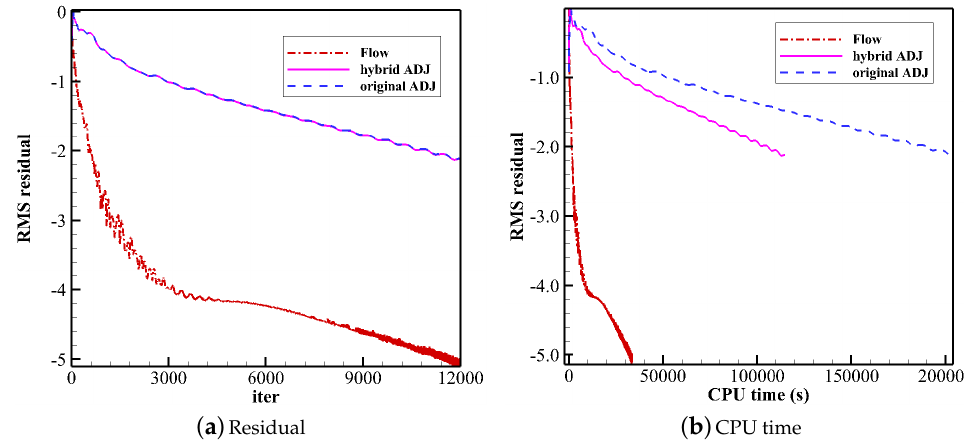
Figure 26. RMS residual convergence histories of both the flow and adjoint solvers ( a ); comparison of CPU time among different solvers for the Aachen turbine ( b ).